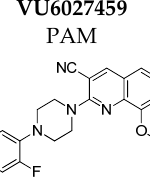
Figure 2. Chemical structures of the last reported mGlu 7 receptor tool compounds [37,40] (NAM— negative allosteric modulator; PAM—positive allosteric modulator). EC 50 —effective concentration 50; IC 50 —inhibitory concentration 50; assay type indicated in parenthesis; rat CL hep—predicted hepatic clearance in rat; Kp(rat)—rat brain/plasma ratio.